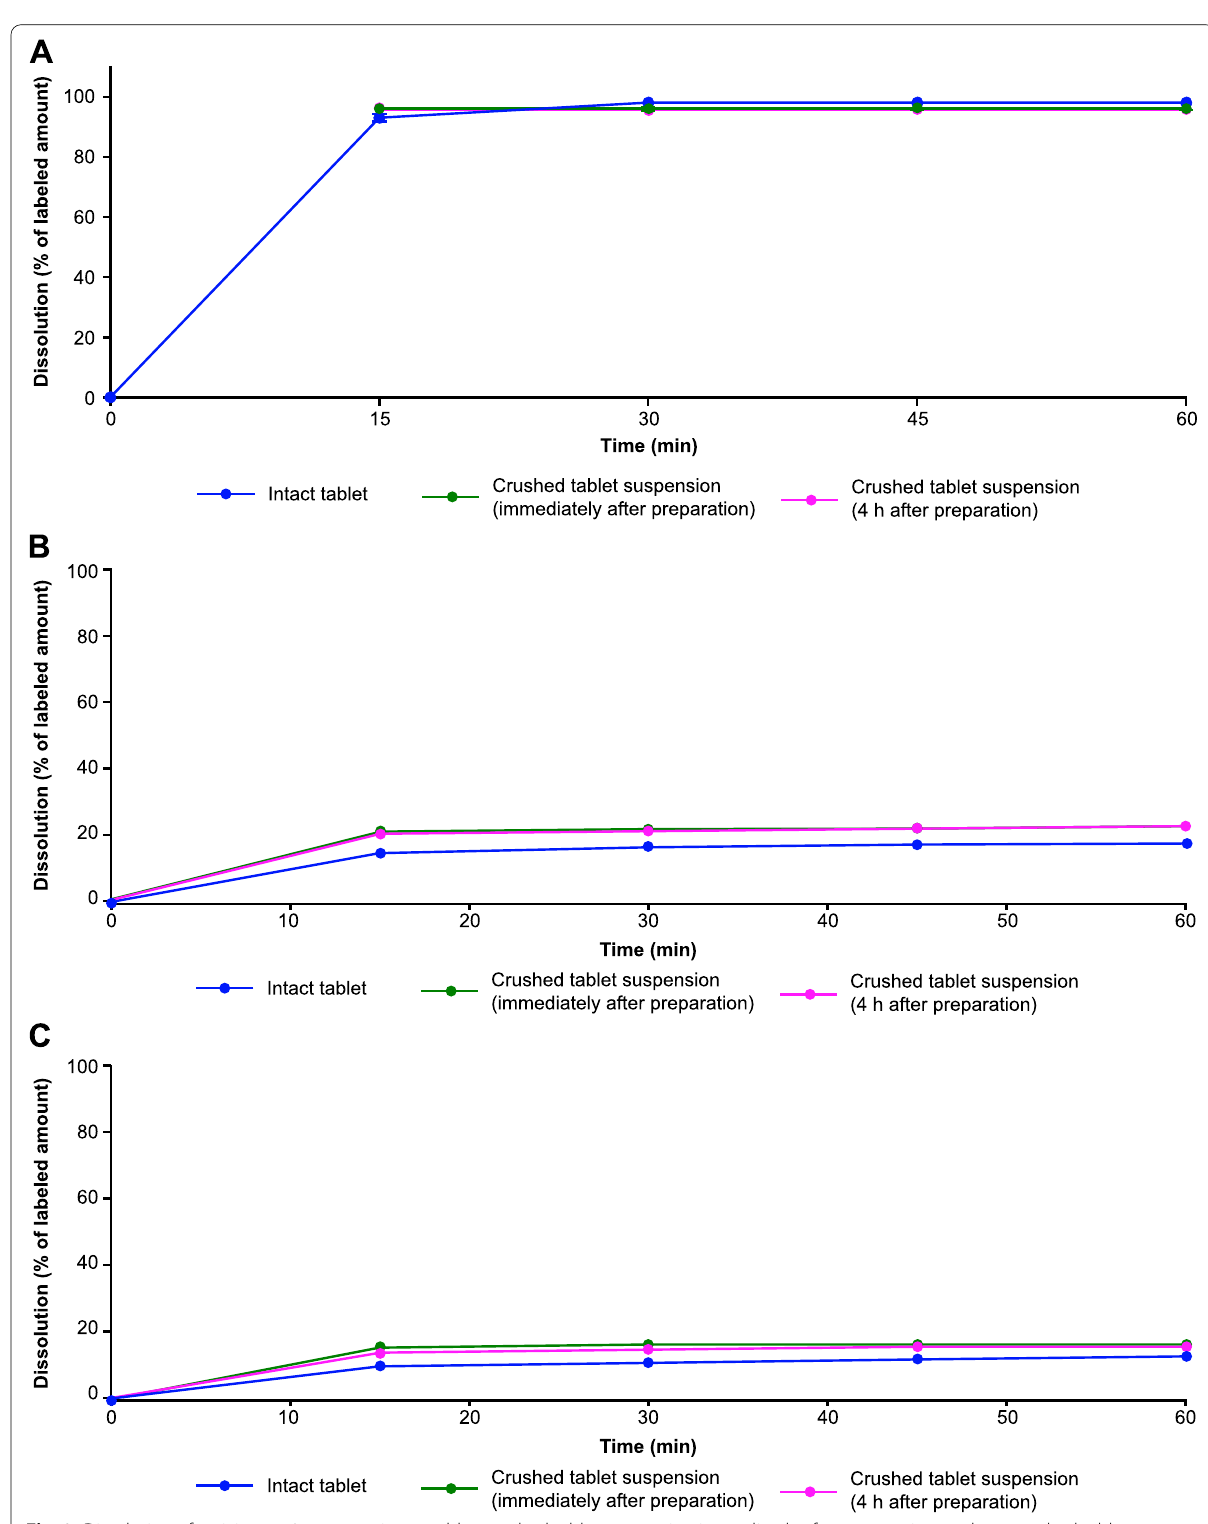
Fig. 2 Dissolution of vericiguat 10 mg as an intact tablet, crushed tablet suspension immediately after preparation, and as a crushed tablet suspension 4 h after preparation (